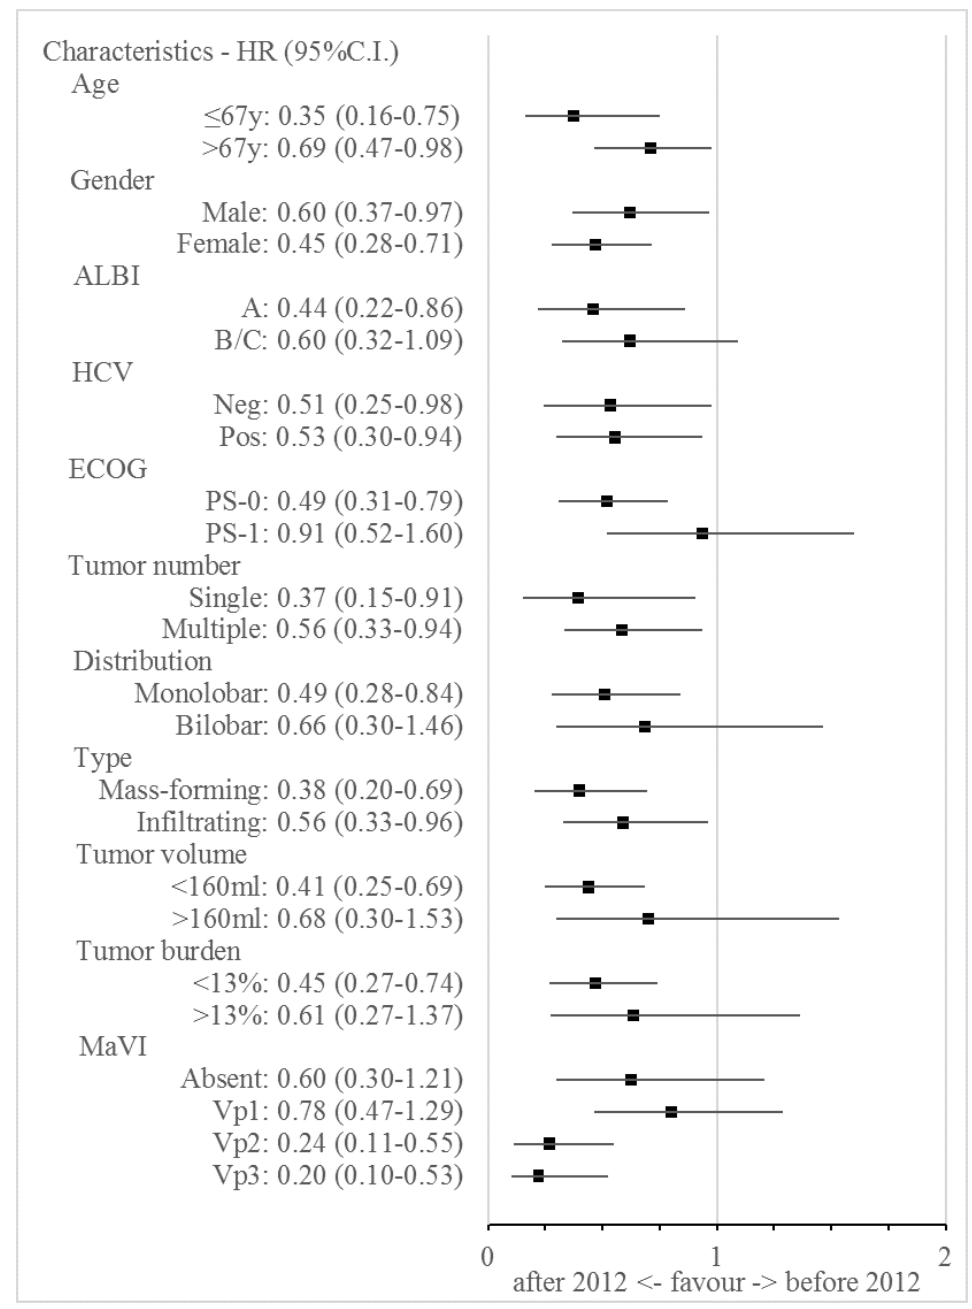
Figure 2. The results of the interaction between the clinical and the radiological characteristics, and the time of treatment in the reweighted study population. The weighted population size of the patients treated before 2012 is equal to that of the patients treated from 2012 onward ( n = 185).